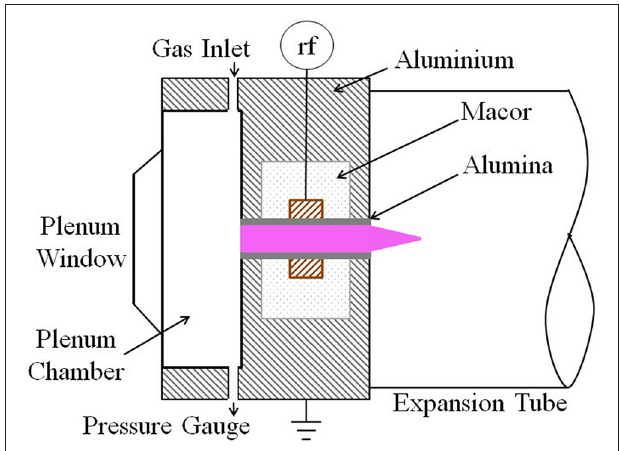
FIGURE 1 | The ‘Pocket Rocket’ device and experimental housing.